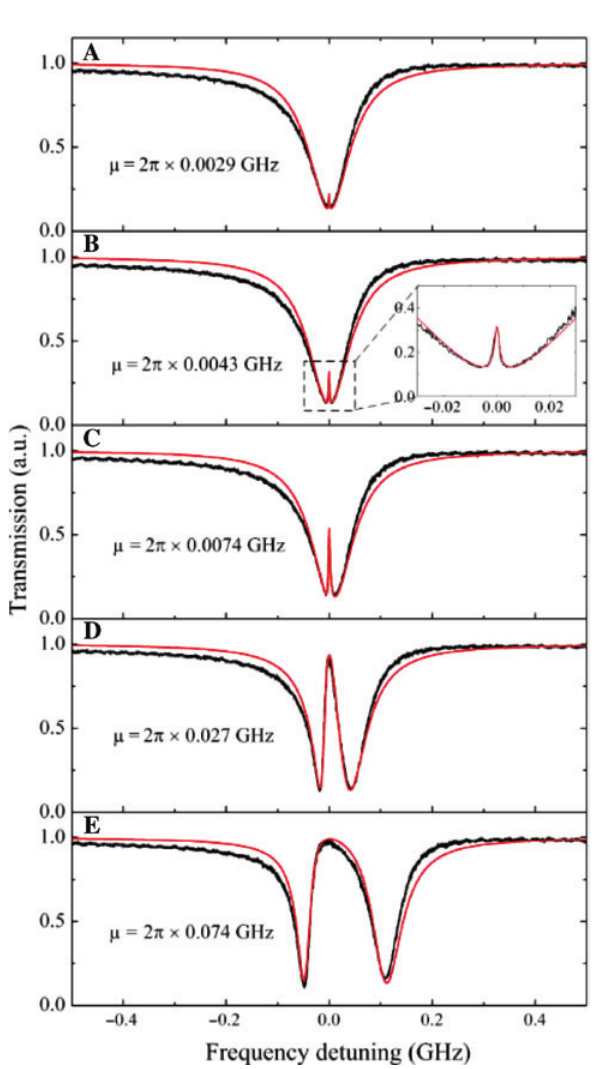
Figure 5: Transmission spectra for different gaps between the coupled microcavities. (A–E) Measured EIT spectra (black lines) of the coupled microcavities for different coupling strengths. (Inset) Close-up to the transparency window with a bandwidth of 2.3 MHz. Theoretical fittings are represented by the red lines calculated from Eq. (5) and in excellent agreement with the experimental